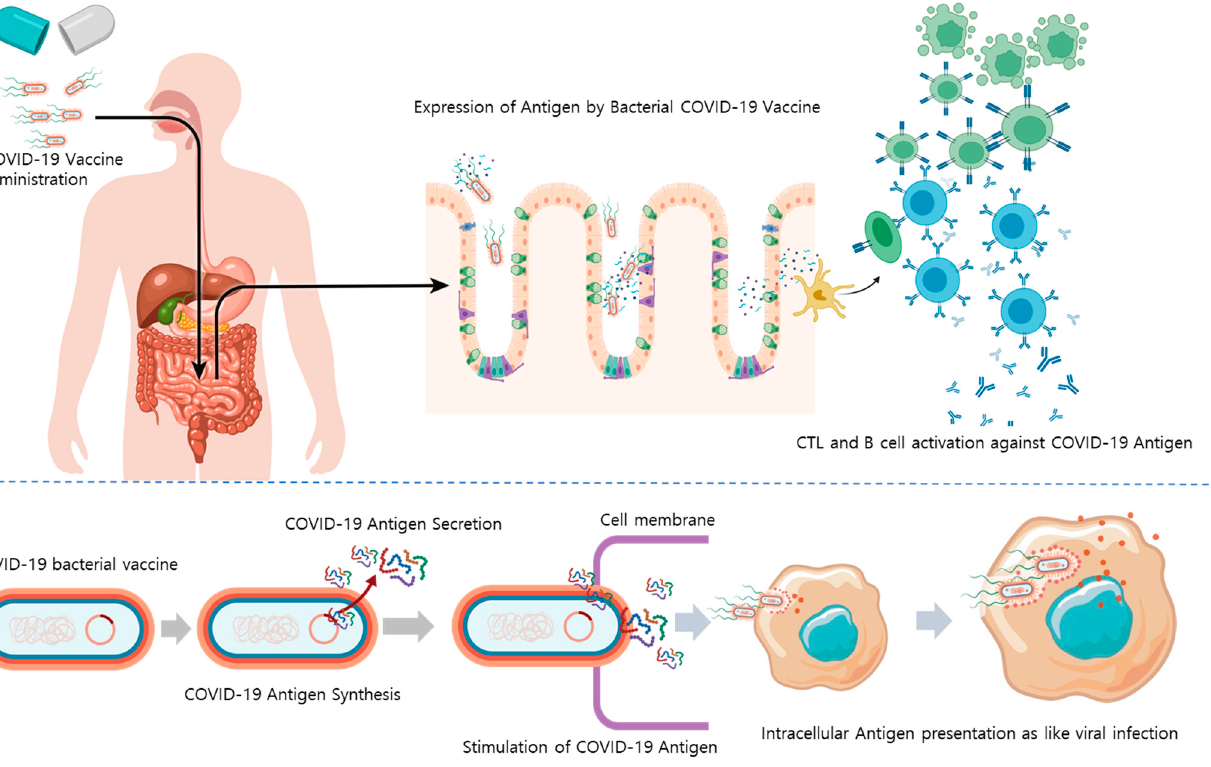
Figure 1. Mode of action of an orally administrated bacterial COVID-19 vaccine. Abbreviations: COVID-19, coronavirus disease 2019; CTL, cytotoxic T-cell.